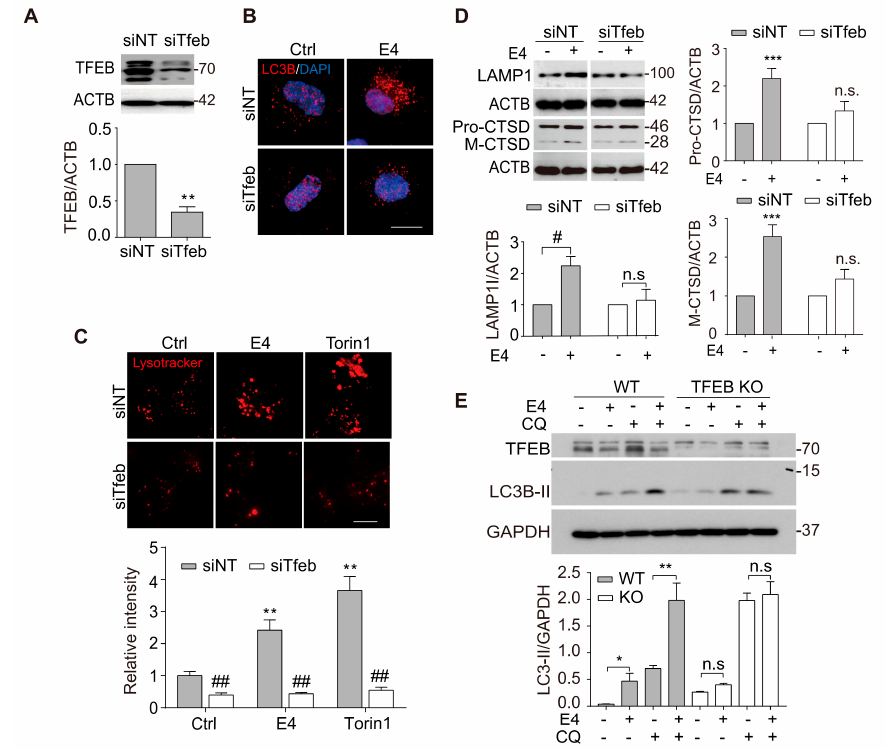
Figure 3. TFEB is required for E4-induced autophagy flux and lysosome biogenesis. ( A ) Transfected N2a cells with nontarget siRNA ( si-NT , 50 nM) and Tfeb siRNA ( siTfeb , 50 nm) for 48 h, and the expression of TFEB was evaluated by western